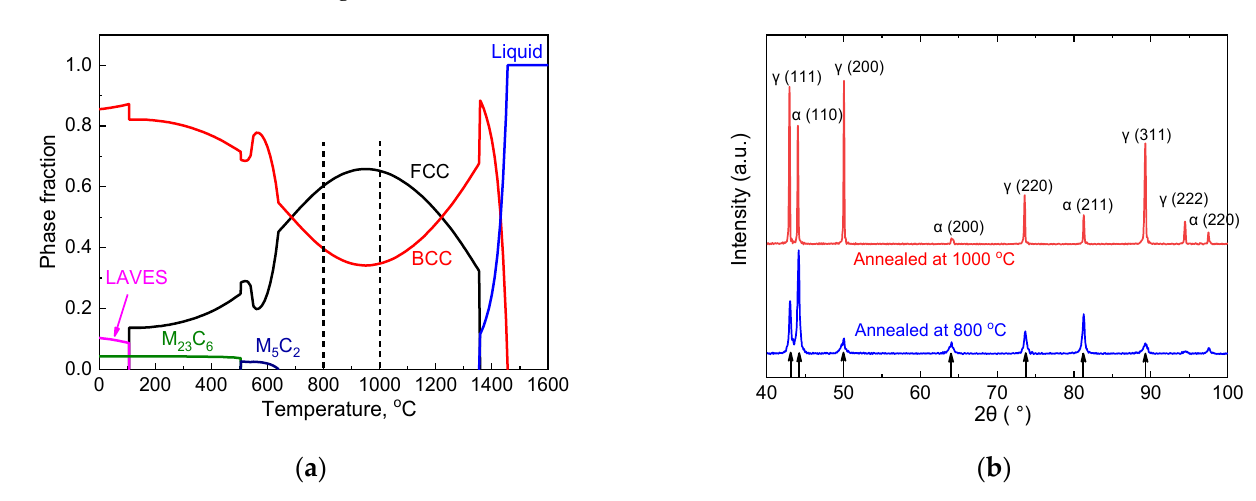
Figure 2. ( a ) Phase fractions of the steel based on an equilibrium thermodynamic analysis as predicted by Thermo-Calc and ( b ) the XRD pattern of the steel annealed at 800 and 1000 °C.